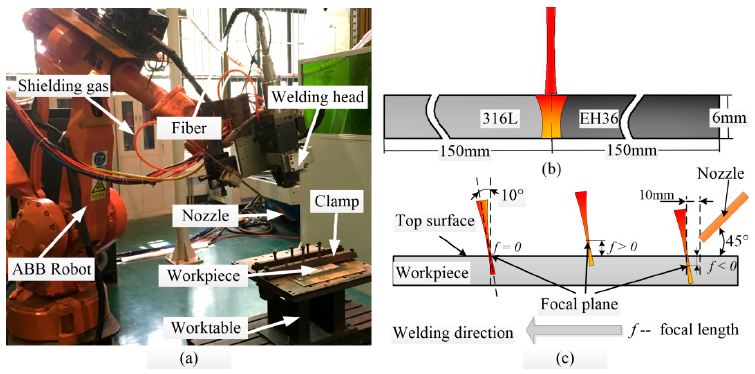
Figure 1. The laser welding setup: ( a ) the laser welding system; ( b ) schematic diagram of the butt welding process; and ( c ) schematic diagram of the focal length and angle of incidence of laser beam. Table 1. Chemical composition of AISI316L austenitic stainless and EH36 (weight in %). Element